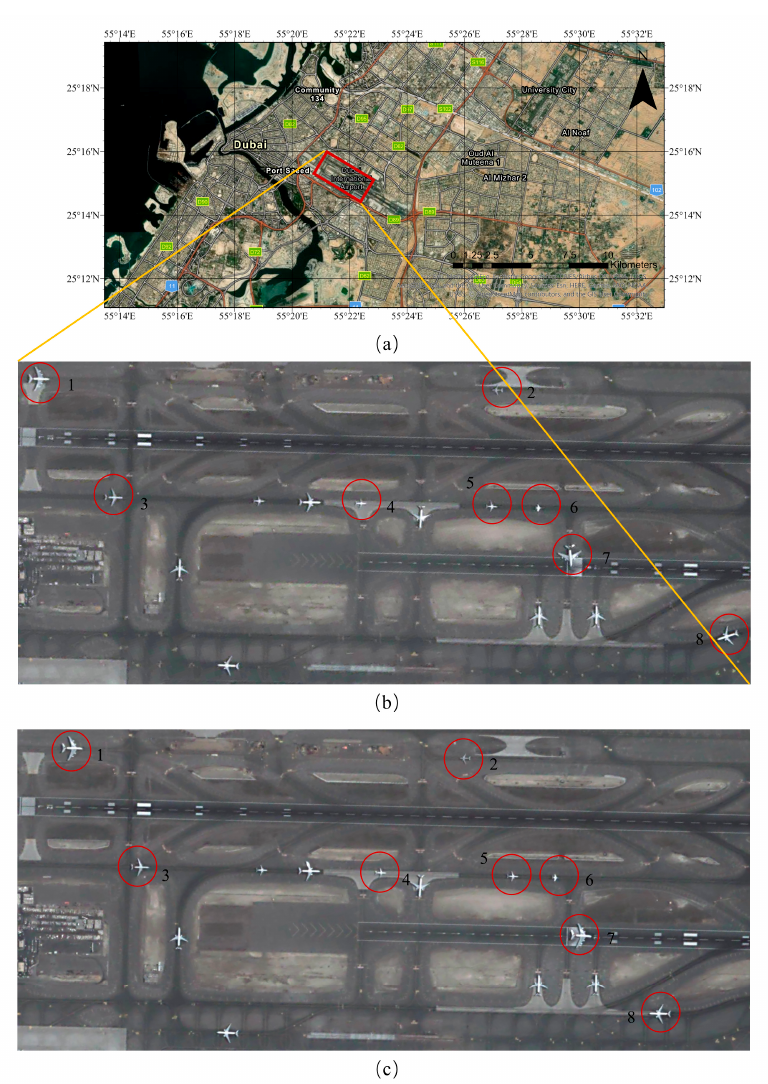
Figure 1. Study area and Jilin-1 satellite video frames: ( a ) the ESRI base map showing the study area of the Dubai International Airport; and ( b , c ) the first and last frames of the Jilin-1 satellite video. All eight moving airplanes are labeled.